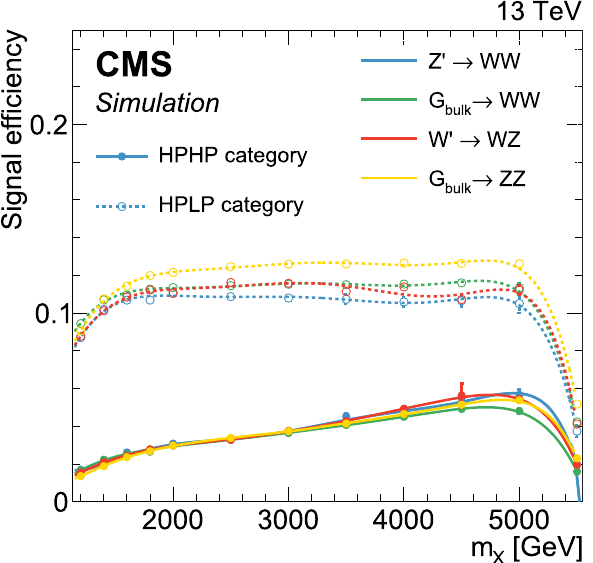
Fig. 6 Totalsignalefficiencyasafunctionof m X afterallselectionsare applied, for signal models with a Z (cid:3) decaying to WW, G bulk decaying to WW, W (cid:3) decaying to WZ , and G bulk decaying to ZZ. The denominator is the number of generated events. The solid and dashed lines show the signalefficienciesfortheHPHPandHPLPcategories,respectively.The decrease in efficiency between 5.0 and 5.5TeV is due to the requirement m jj < 5500GeV